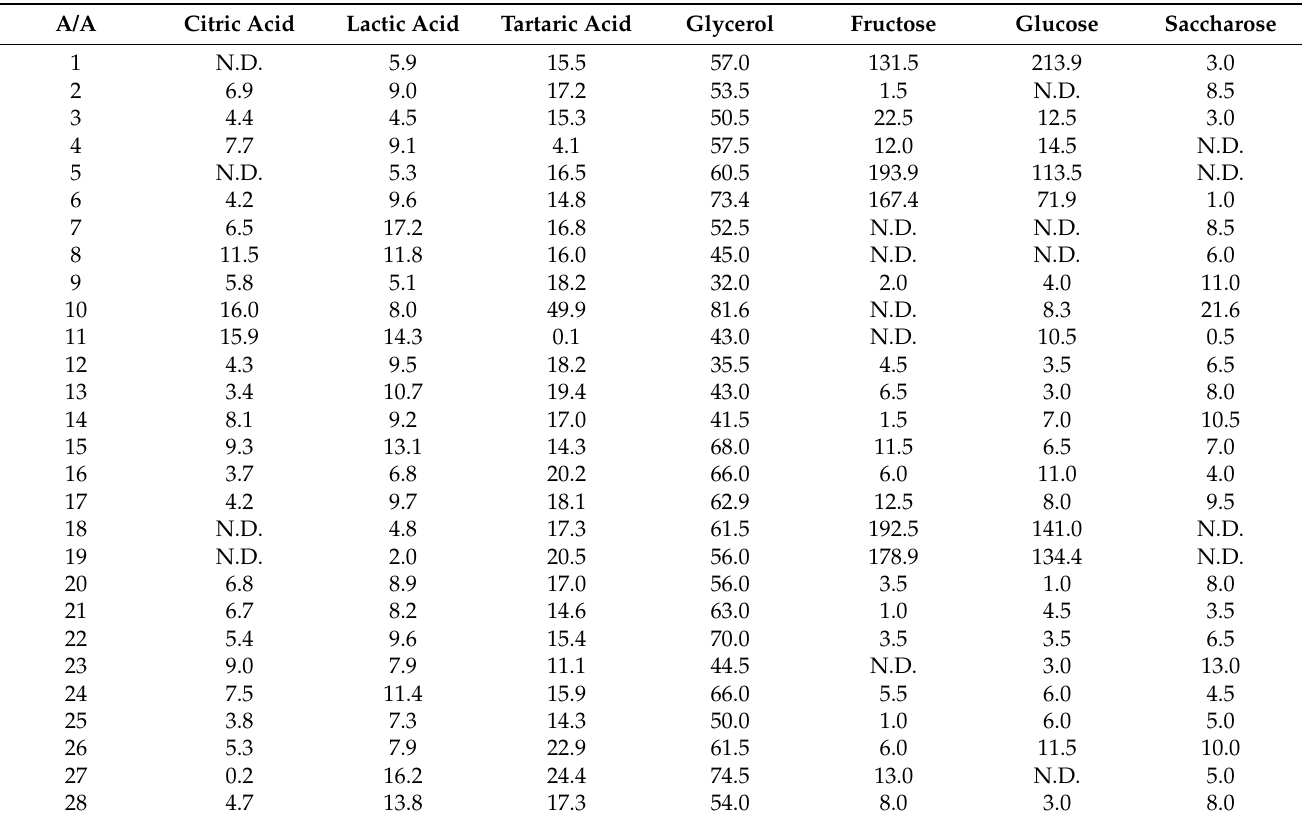
Table 4. Organic acid and sugar content of the sediment extracts of wine lees expressed as mg g − 1 of dry